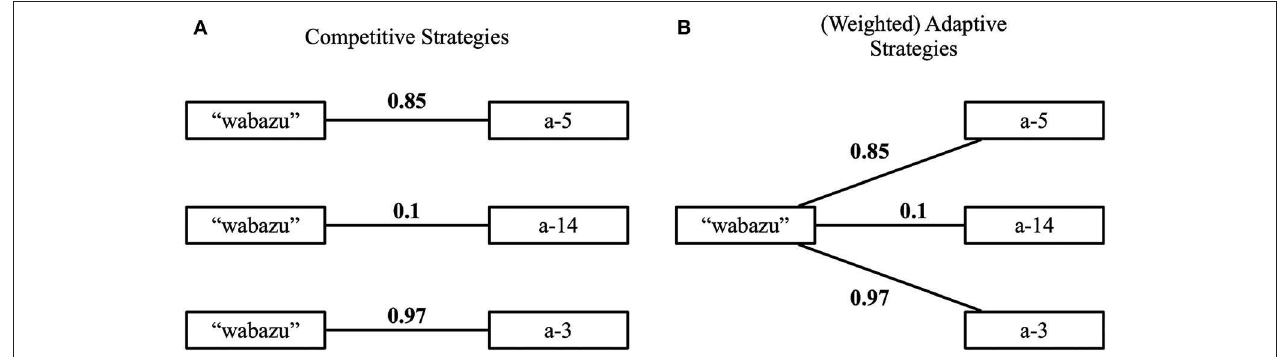
FIGURE 1 | (A) Competitive strategies enumerate competing hypotheses. (B) Adaptive strategies allow the meaning to be shaped gradually. By adding weights, this can be done in a more fine-grained manner.